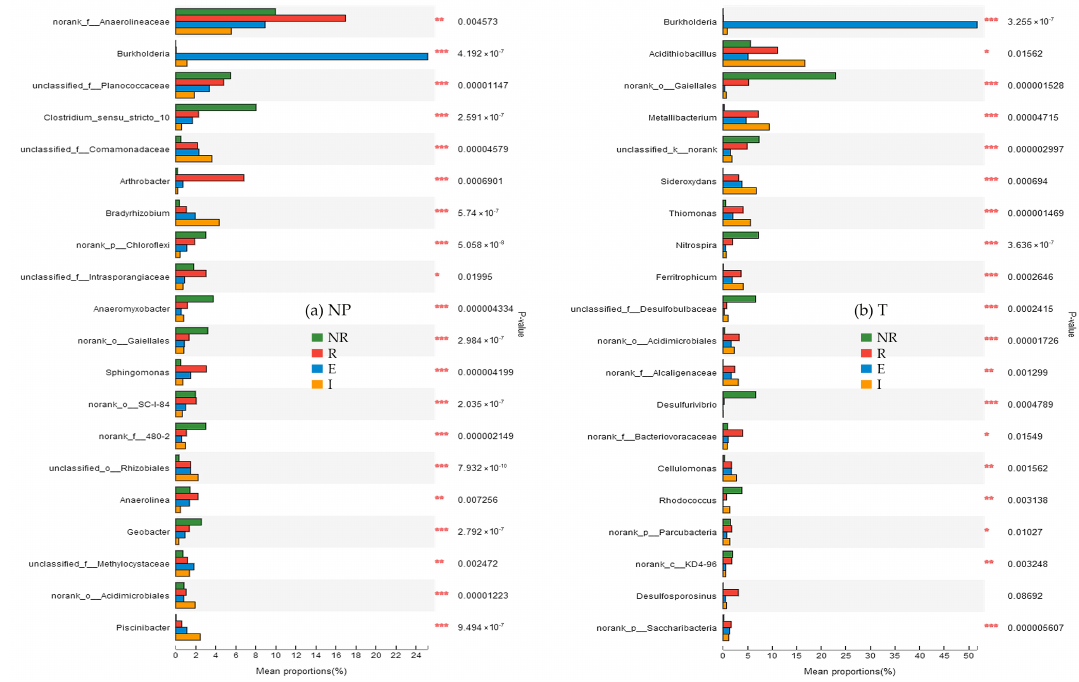
Figure 6. One-way ANOVA bar plots showing the differences in species abundance among the non-rhizosphere (NR), rhizosphere (R), external layer of iron plaque (E) and internal layer of iron plaque (I) in ( a ) the non-polluted soil (NP) and ( b ) the tailing soil (T). The ordinate shows taxon names of different levels, and the abscissa shows the abundance percentage of a taxon in the sample. (0.01 < p ≤ 0.05 *, 0.001 < p ≤ 0.01 **, p ≤ 0.001